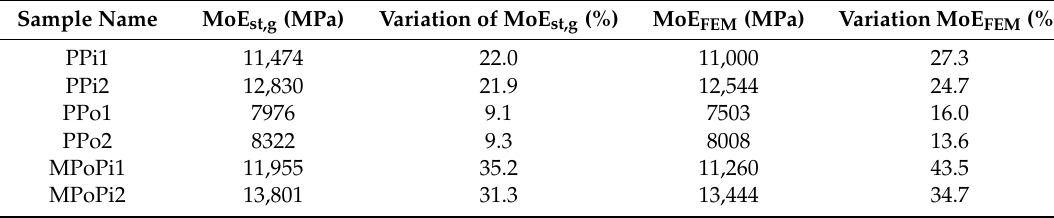
Table 5. Comparison of experimental and numerical moduli of elasticity without considering the shear modulus and their variation in % respect to the static modulus MoE st . MoE st : static modulus of elasticity. MoE st,g : global static modulus of elasticity. MoE FEM : calibrated modulus of elasticity without using